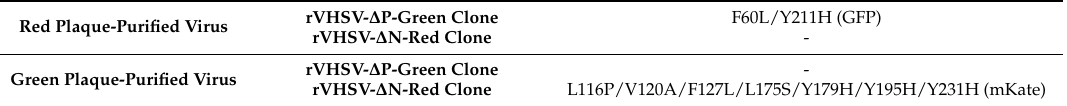
Table 2. Amino acid changes observed in fluorescent proteins in Red and Green plaque purified viruses. Red Plaque-Purified Virus